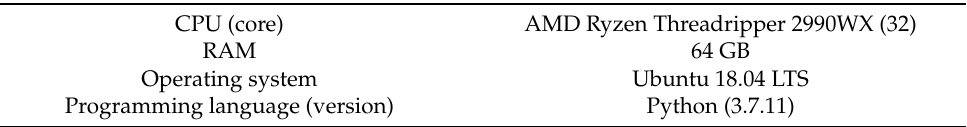
Table 3. Experiments